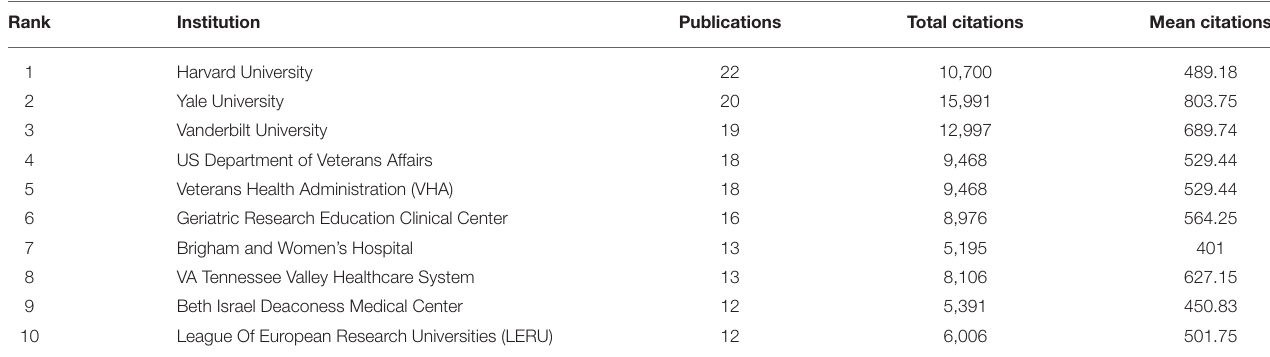
TABLE 1 | Institution with top-10 number of papers included in the top-100 articles.